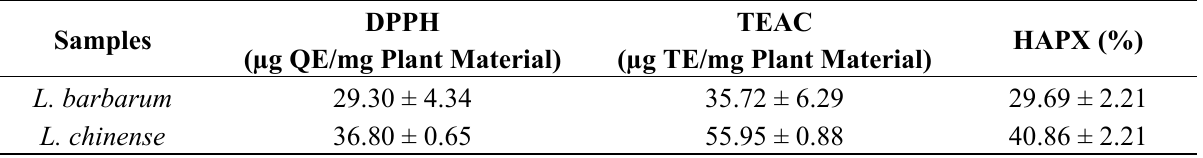
Table 3. Antioxidant capacity parameters obtained using several methods for studied samples.